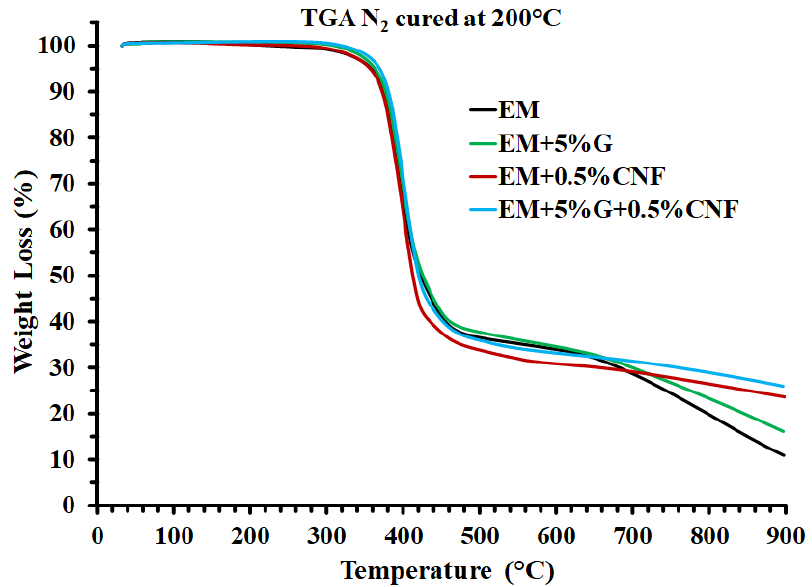
Figure 4. TGA curves in nitrogen of the epoxy samples isothermally solidified.